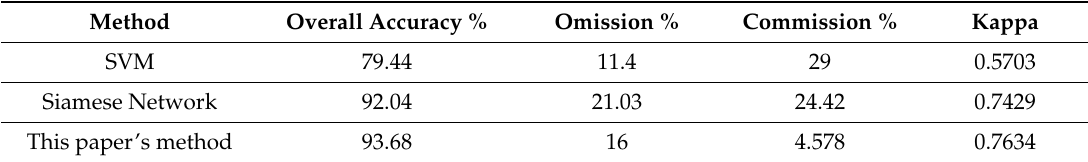
Table 3. Experimental results of three methods on the public